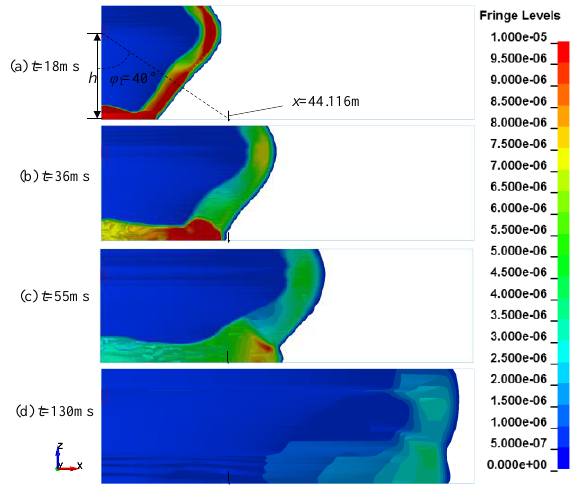
Figure 5. Reflected pressure contours images of the shock wave explosion above the rigid ground.